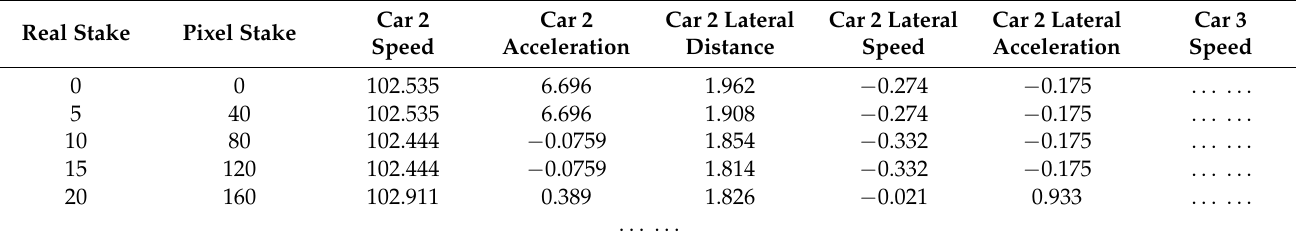
Table 9. Data file for vehicle